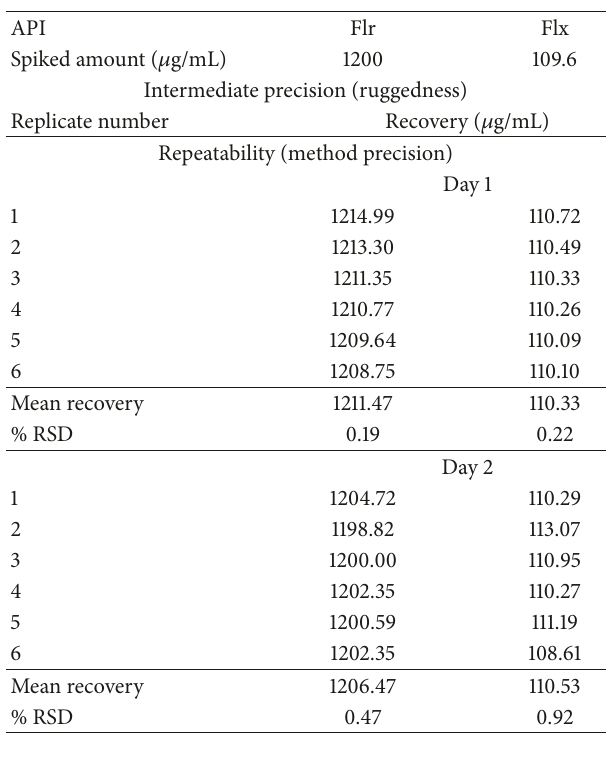
Table 6: Evaluation of precision of the method developed in this